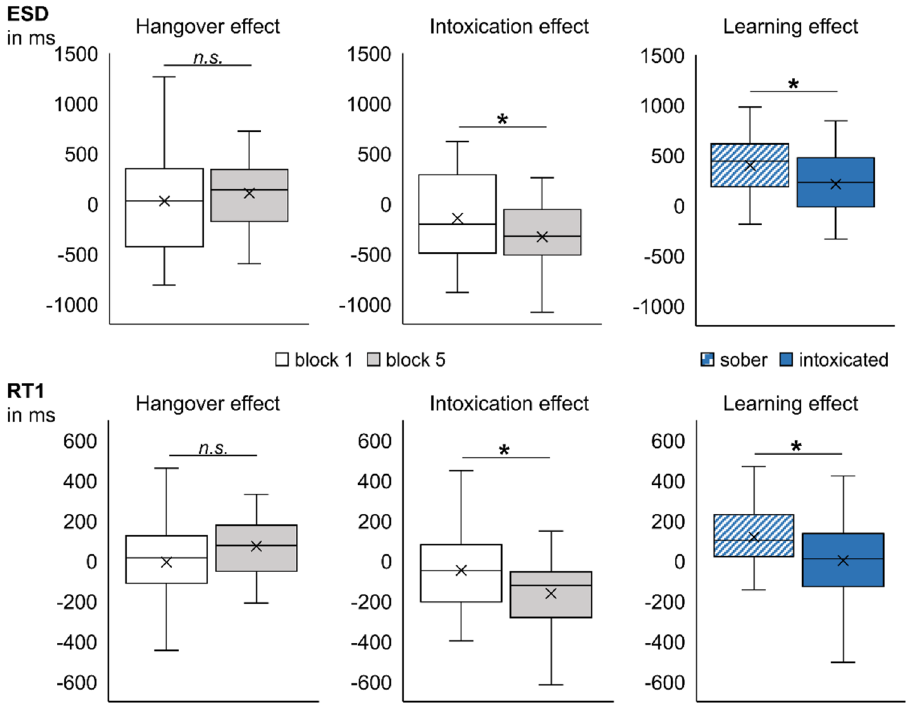
Figure 3. Illustration of the three-way interaction of alcohol administration x block x alcohol manipulation group found for the entire sequence duration (ESD in milliseconds; upper graph) and for the first motor response time (RT1 in milliseconds; lower graph). While there were no overall hangover-induced effects on block number, intoxication-induced impairments (i.e., the difference between sober and intoxicated performance) were significantly larger in block 5 than in block 1 for both depicted measures. The size of the learning effect (i.e., the difference between block 1 and block 5) was significantly smaller at the intoxicated appointment than at the sober appointment. This allows for the conclusion that the deficits in learning motor response sequences generation arose mainly from intoxication-induced impairments in response selection and planning processes, but not from motor response execution processes, as these ESD effects were only observed in the RT1, but not in the MSD